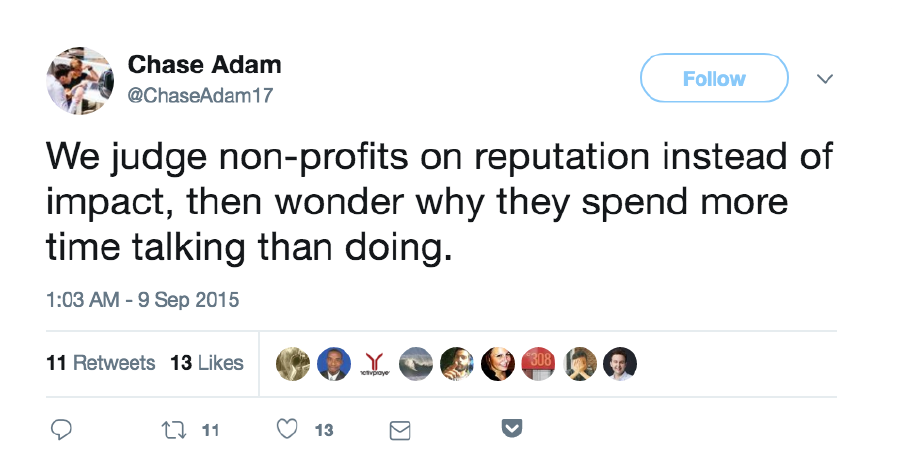
Figure 3. A tweet from Chase Adam speaks to the organization’s embrace of Silicon Valley values and skepticism about